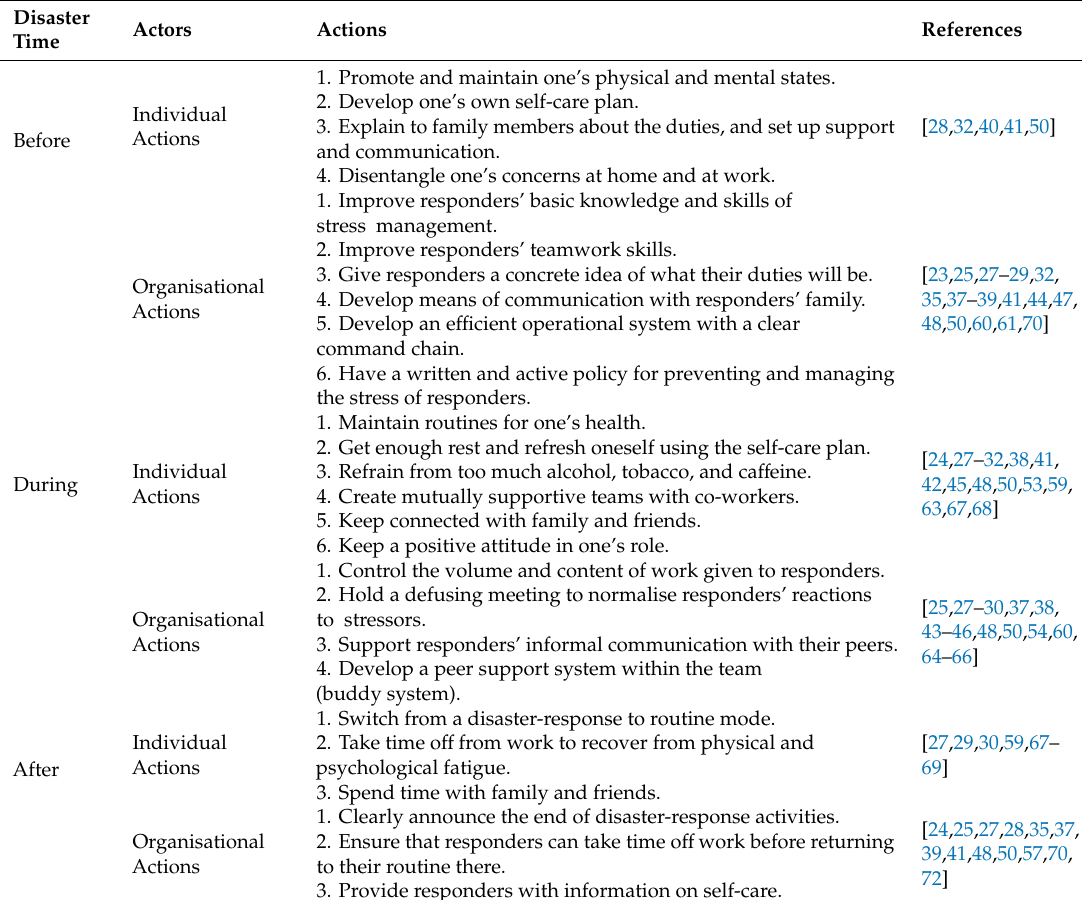
Table 2. Actions for Goal 2: Reducing stressors and preventing chronically stressful situations. Disaster Time